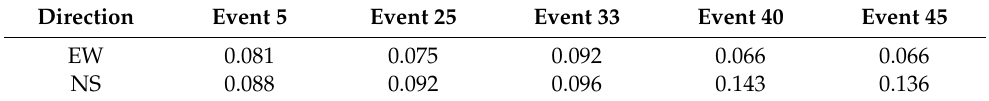
Table 4. Fitting error for different events and directions of the general